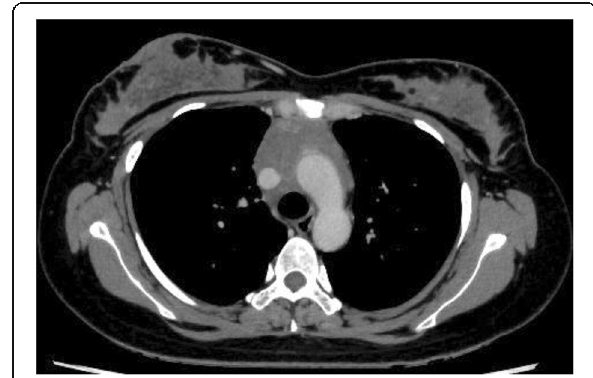
Fig. 2 CT scan following chemotherapy showing significant regression of the mass and decreased compression of the